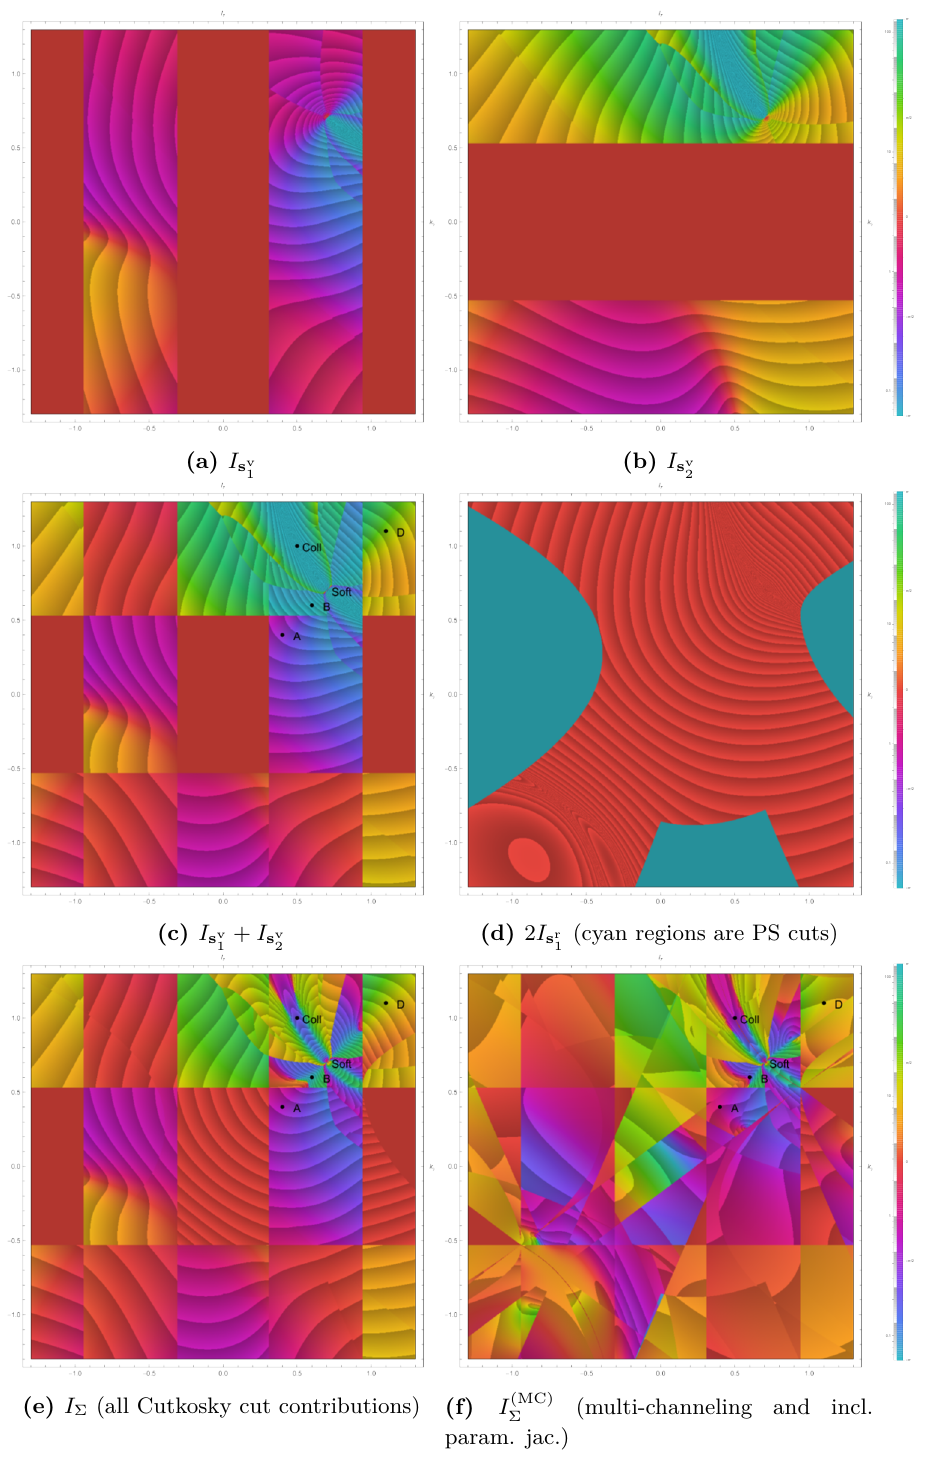
Figure 15. Complex 2D plots of the Local Unitarity double-triangle supergraph integrand from ) , (0 , 1 √ α Loop evaluated at ( ~k,~l ) = ((0 , k y , 1 √ , l z )) with a contour deformation enabled. The 2 2 colour shading denotes logarithmic isolines of the norm of the integrand while the colour indicate the value of its complex